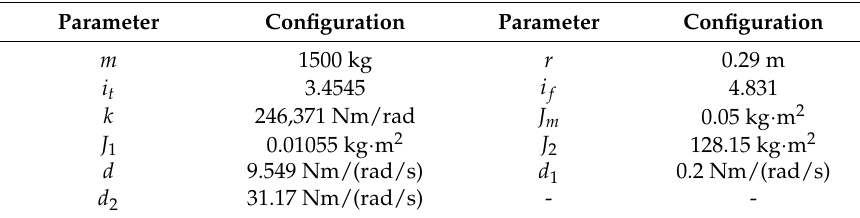
Table 4. Critical parameters of EV drivetrain.